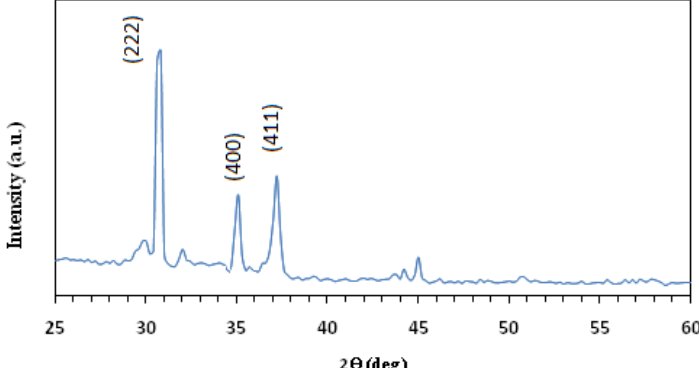
Fig. 3: X-Ray diffraction of In T=400 °